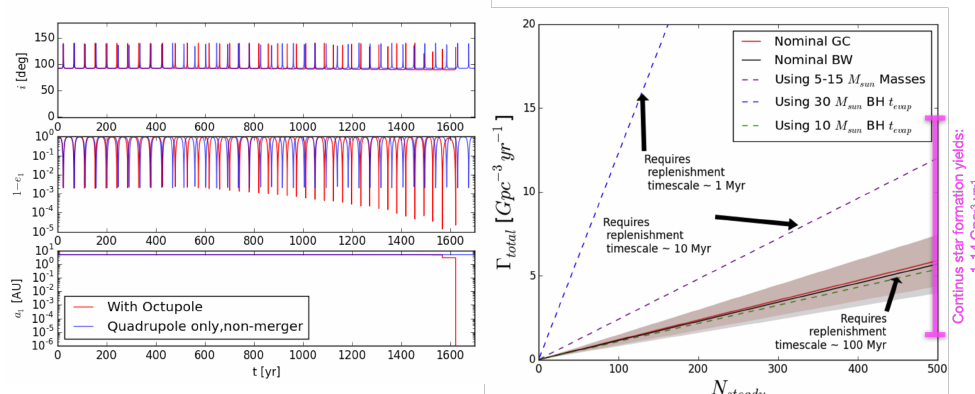
Figure 12. ( Left panel ) A representative example from [292], that depicts the evolution of a BBH while solving the deafening equations up to the octupole level of approximation (red) and only up to the quadrupole level of approximation (blue). As shown, the octupole-level evolution results in a merger after 1623 years, while the quadrupole-level approximation never merges. ( Right panel ) Volumetric BH merger rate as a function of the number of BBHs. This rate represents Monte Carlo results from Hoang et al, ApJ, 2018, 856(2), 140 ©AAS [292]. Reproduced with